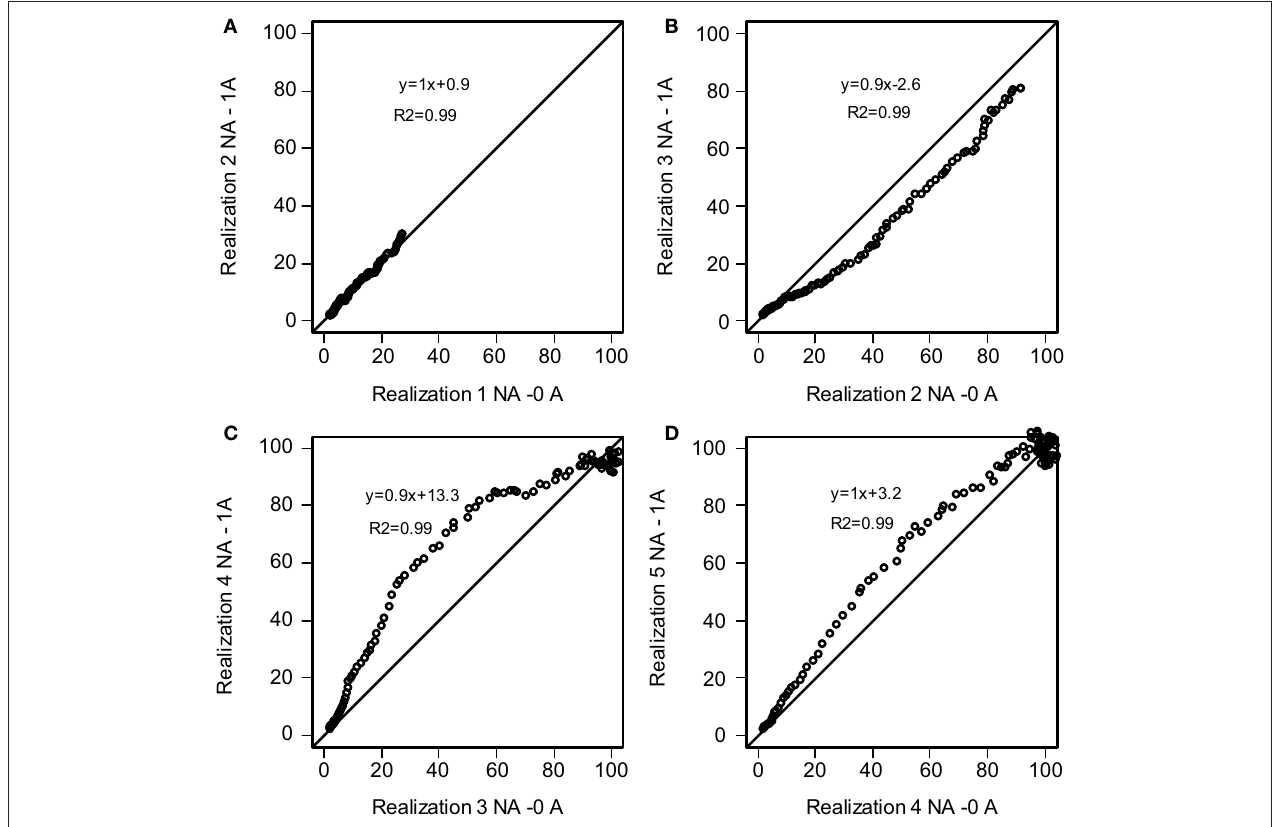
FIGURE 2 | Linear relationships of two scenario parameters (with and without withdrawal of adopters) in stochastic simulations based on a logistic function to calculate the new area with SWRT over time. (A) y-axis represents output with two new adopters and one withdrawal against one new adopter in x-axis, (B) y-axis represents output with three new adopters and one withdrawal against two new adopter in x-axis, (C) y-axis represents output with four new adopters and one withdrawal against three new adopter in x-axis, and (D) y-axis represents output with five new adopters and one withdrawal against four new adopter in x-axis. The straight line represents a perfect relationship